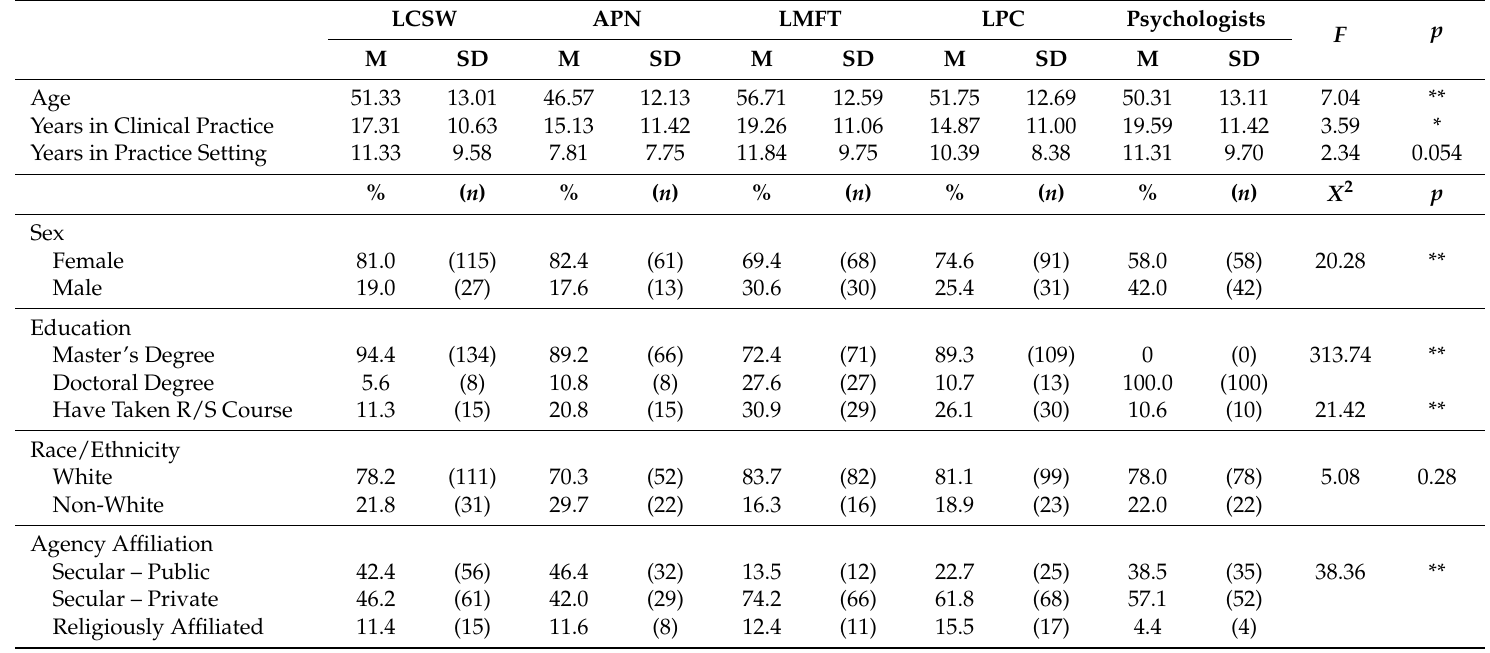
Table 1. Descriptive Characteristics of Helping Professions in